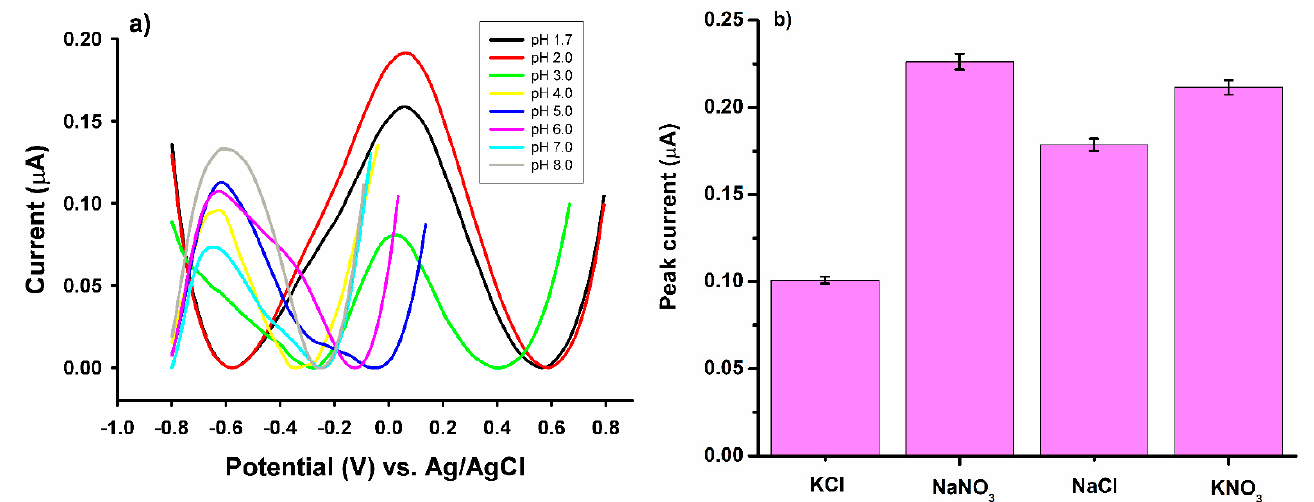
Figure 5. ( a ) DPVs of 10 -4 mol L -1 thiamine in PIX/AuNPsnGr in PBS at pH values of 1.7, 2.0, 3.0, 4.0, 5.0, 6.0, 7.0, and 8.0; ( b ) the influence of the supporting electrolyte (0.1 mol L -1 NaCl, KCl, NaNO 3 , and KNO 3 ) on the electrooxidation of 10 -4 mol L -1 thiamine (pH 2.0 PBS).